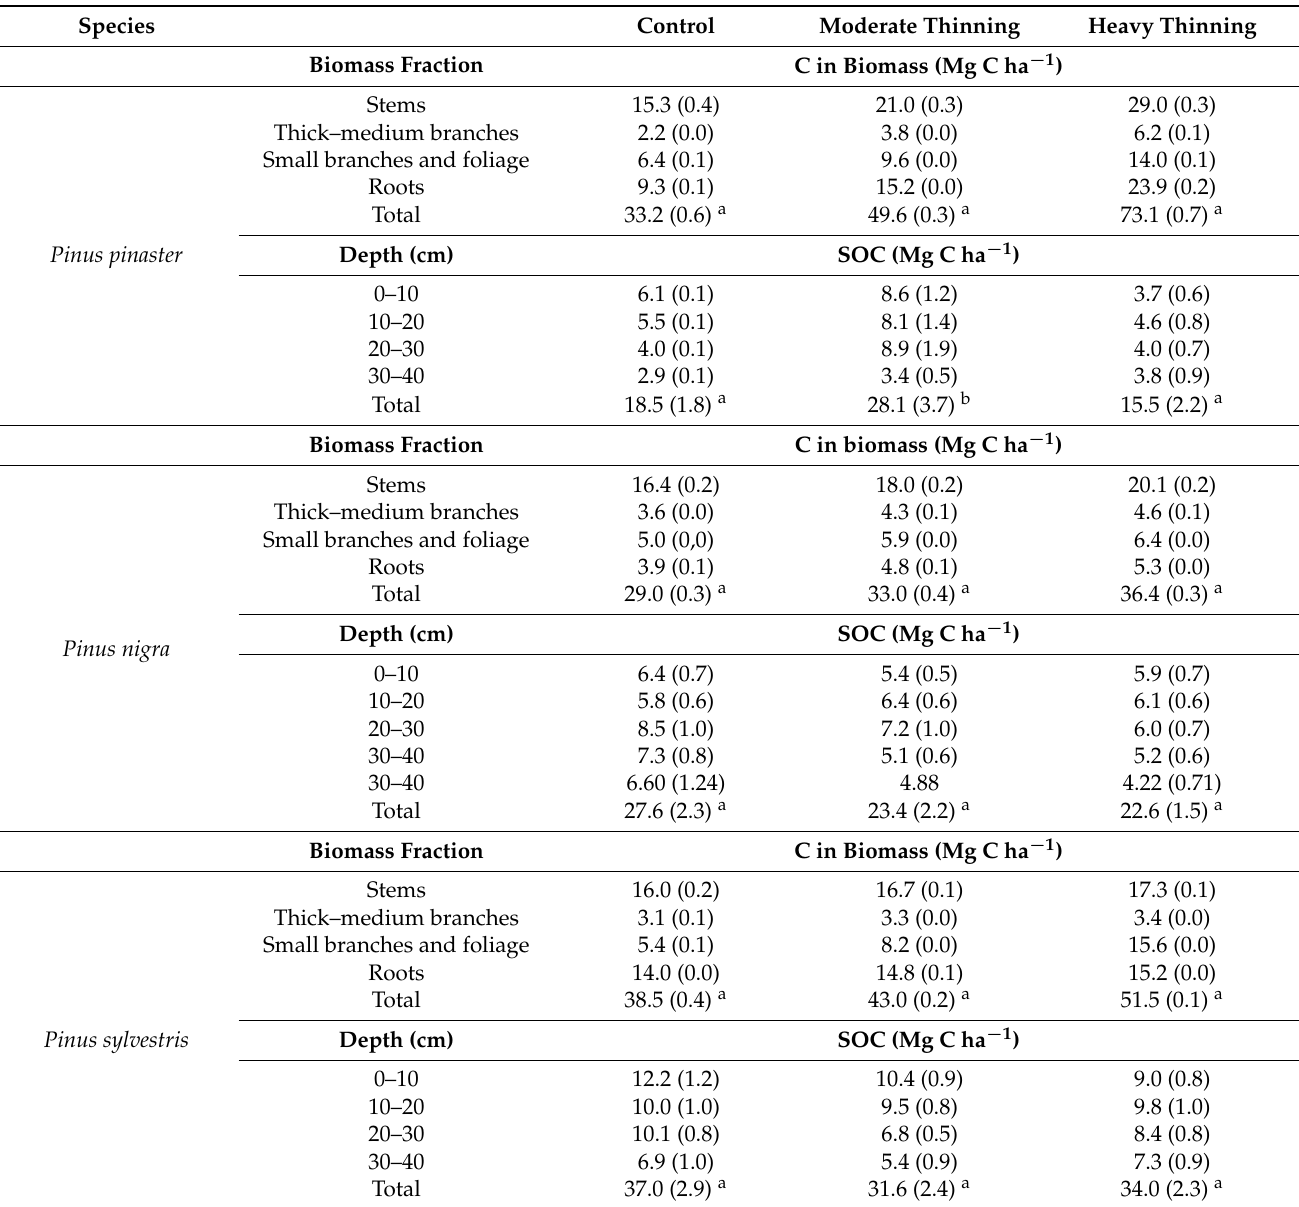
Table 2. Combination of the structural characteristics and biomass C stock of Pinus spp. according to thinning intensities of basal area percentage removed (control or unthinned plots 0%; moderate thinning 30%; heavy thinning 60%) and quantification of soil organic carbon by depth horizon per soil sampling plot at Sª de Los Filabres (Almeria, Spain). Values are the means ± standard error (in brackets), and superscripts (a, b) indicate when pairwise comparisons were significantly